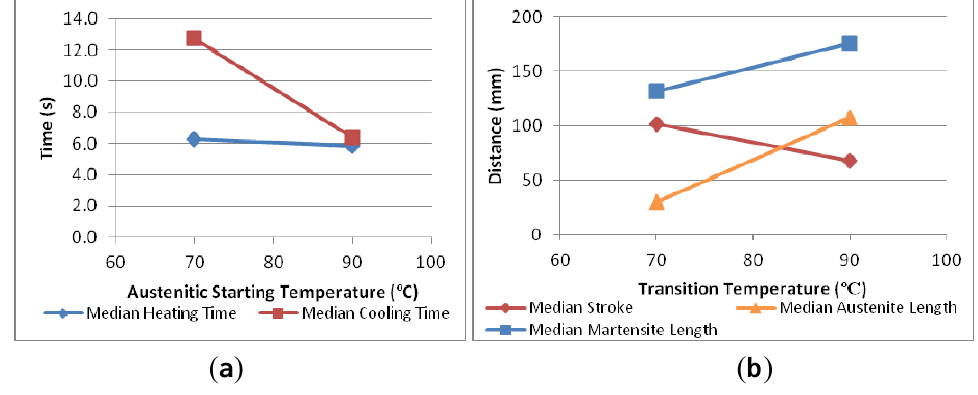
Figure 9. Experimental results from the transition temperature manipulation. ( a ) (Left) The averaged heat and cooling times. ( b ) (Right) The averaged strokes, martensite lengths and austenite